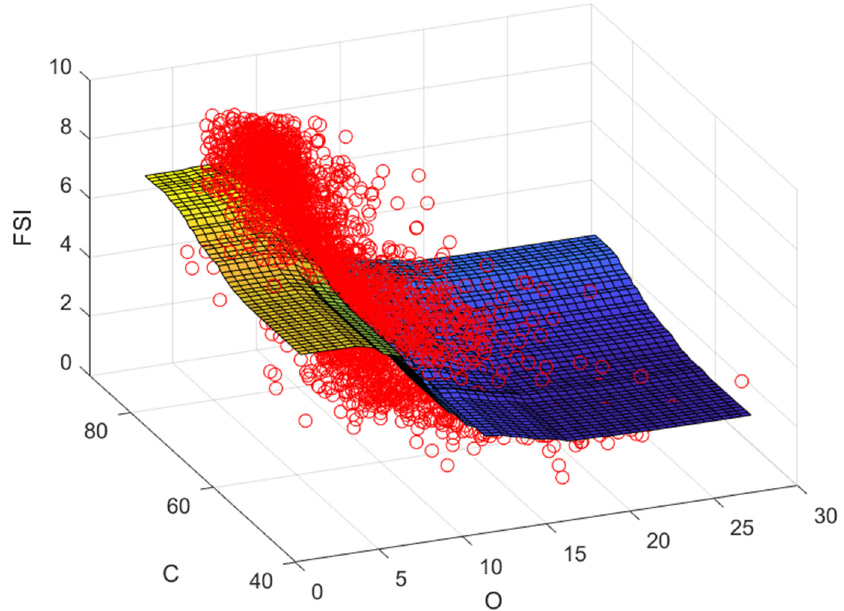
Figure 11. Bivariate partial dependence plot showing the effect of the two most influential predictors on the free swelling index of coal. The observed data are indicated by ‘o’ markers.